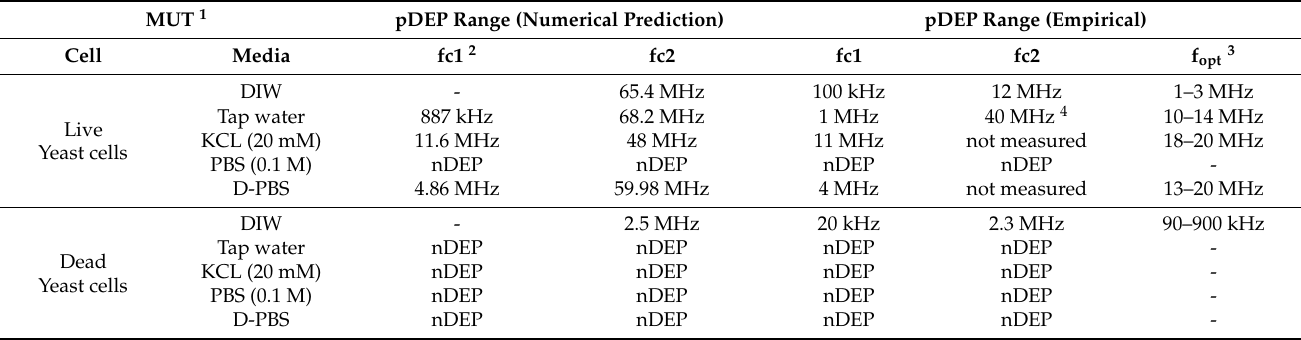
Table 3. DEP characterization results for yeast cell suspensions.